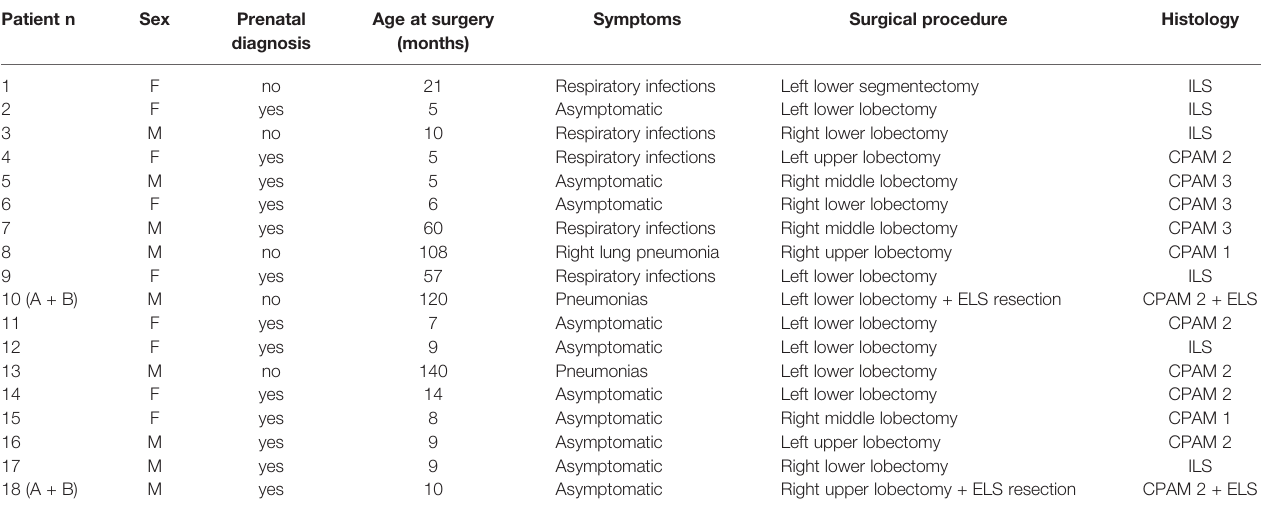
TABLE 1 | Clinical features and histopathology of patients with congenital lung